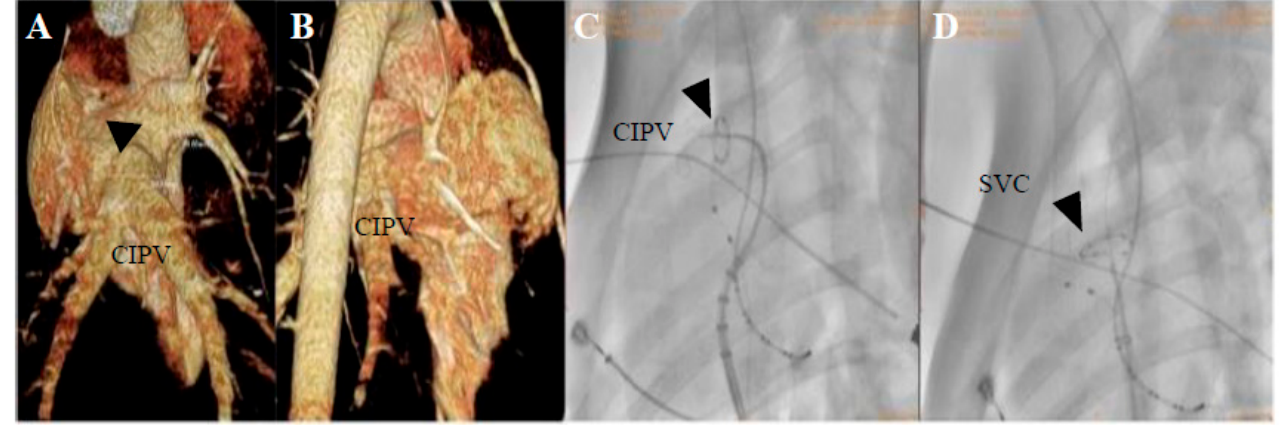
Figure 2. Pulmonary vein computed tomography angiography (CTA) and DSA images with PFA are shown. ( A , B ) CTA imaging for the CIPV anatomical measurements. ( C , D ) DSA is used for catheter positioning, CIPV and SVC ablations were performed during